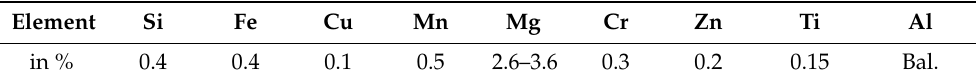
Table 1. Chemical composition of EN AW-5754 H22.